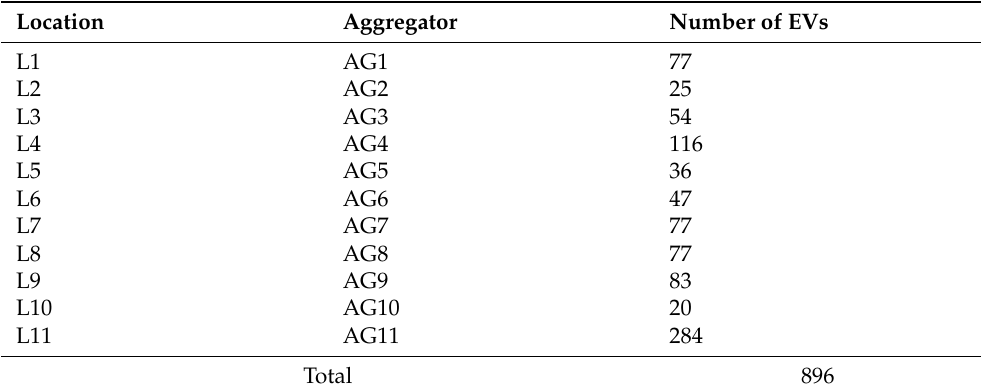
Table 2. EV penetration in the KEPCO X S/S-Z D/L